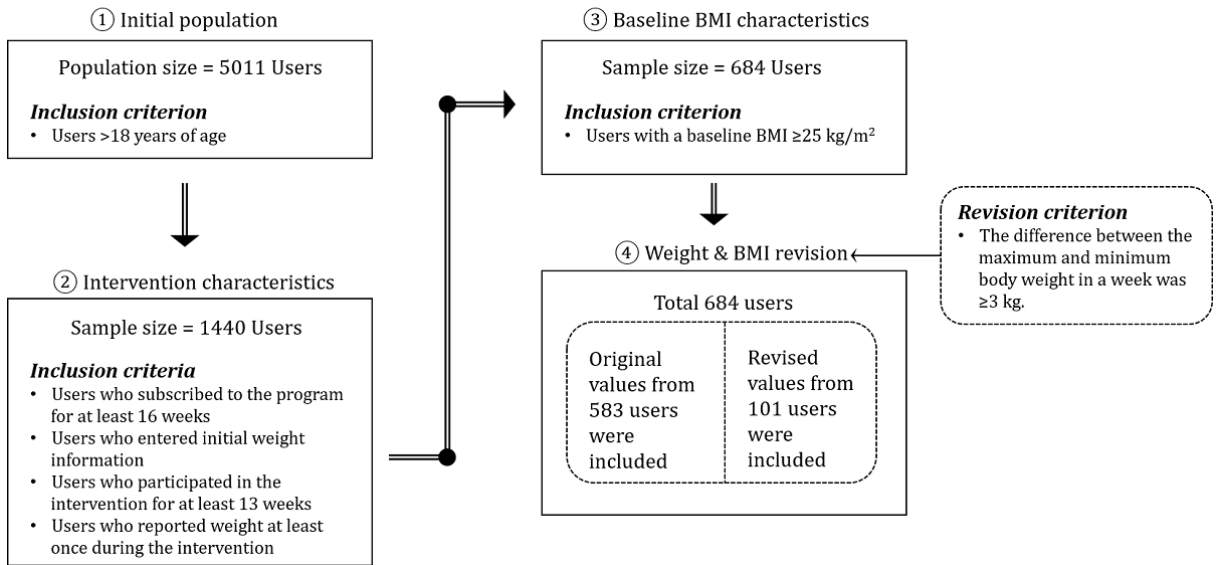
Figure 1. Study sample selection